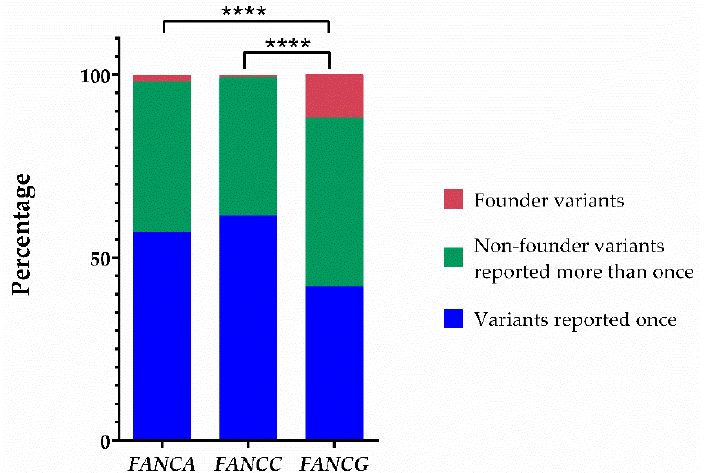
Figure 4. The proportion of variants with founder effect in FANCG is the highest among the most frequently reported genotypes. Proportions of founder pathogenic variants, non-founder pathogenic variants reported more than once, and pathogenic variants reported just once in FANCA , FANCC , and FANCG . The significance level of Fisher’s exact test is represented by four asterisks ( p < 0.0001). FANC32 patient was the third of four children, born to non-consanguineous